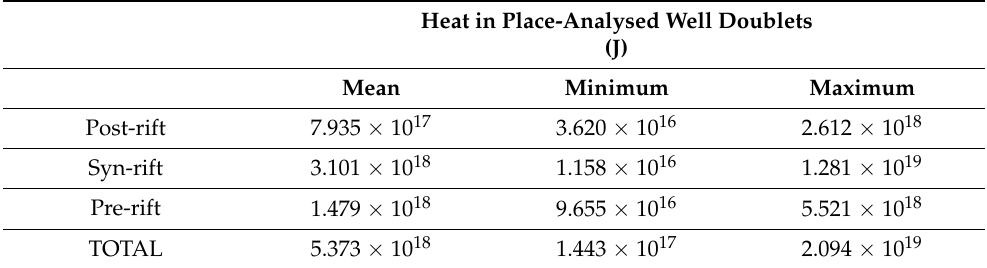
Table 3. Heat-in-place probability distribution of analysed well doublets.